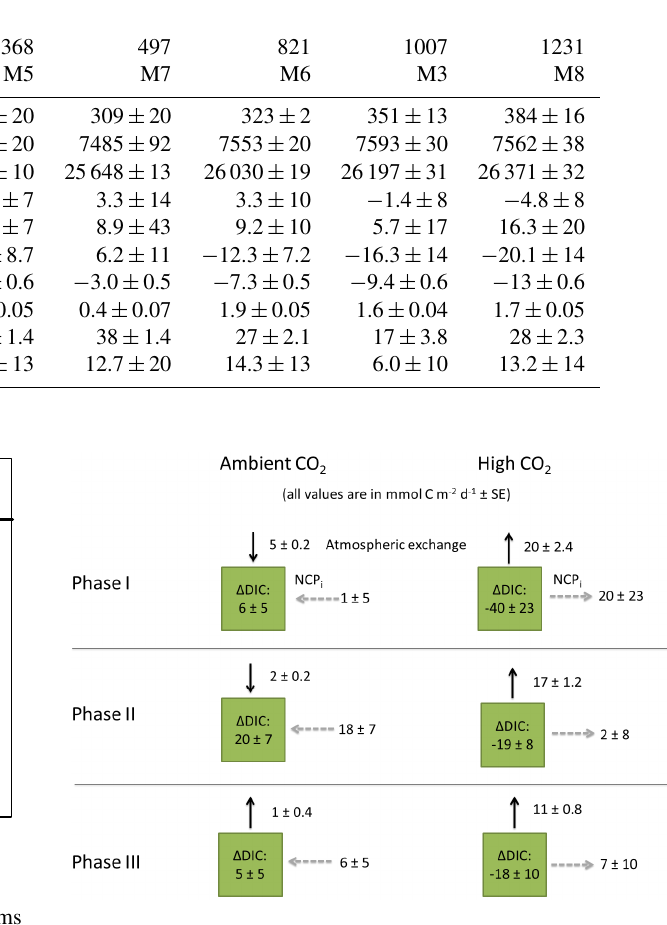
Figure 3. Change in DIC pool and the atmospheric CO 2 ex- change (Fig. 2). All values are average mmolCm − 2 day − 1 ± SE for the three different phases ( n = 13, 8, and 7 for phases I, II, and III, respectively) in the control mesocosms (M1 + M5) and high- CO 2 mesocosms (M3 + M8). Solid black arrows indicate measured fluxes. Dashed grey arrows are estimated by closing the budget and indicate the net community production based on inorganic carbon budget (NCP i ), which equals biological uptake or release of CO 2 .